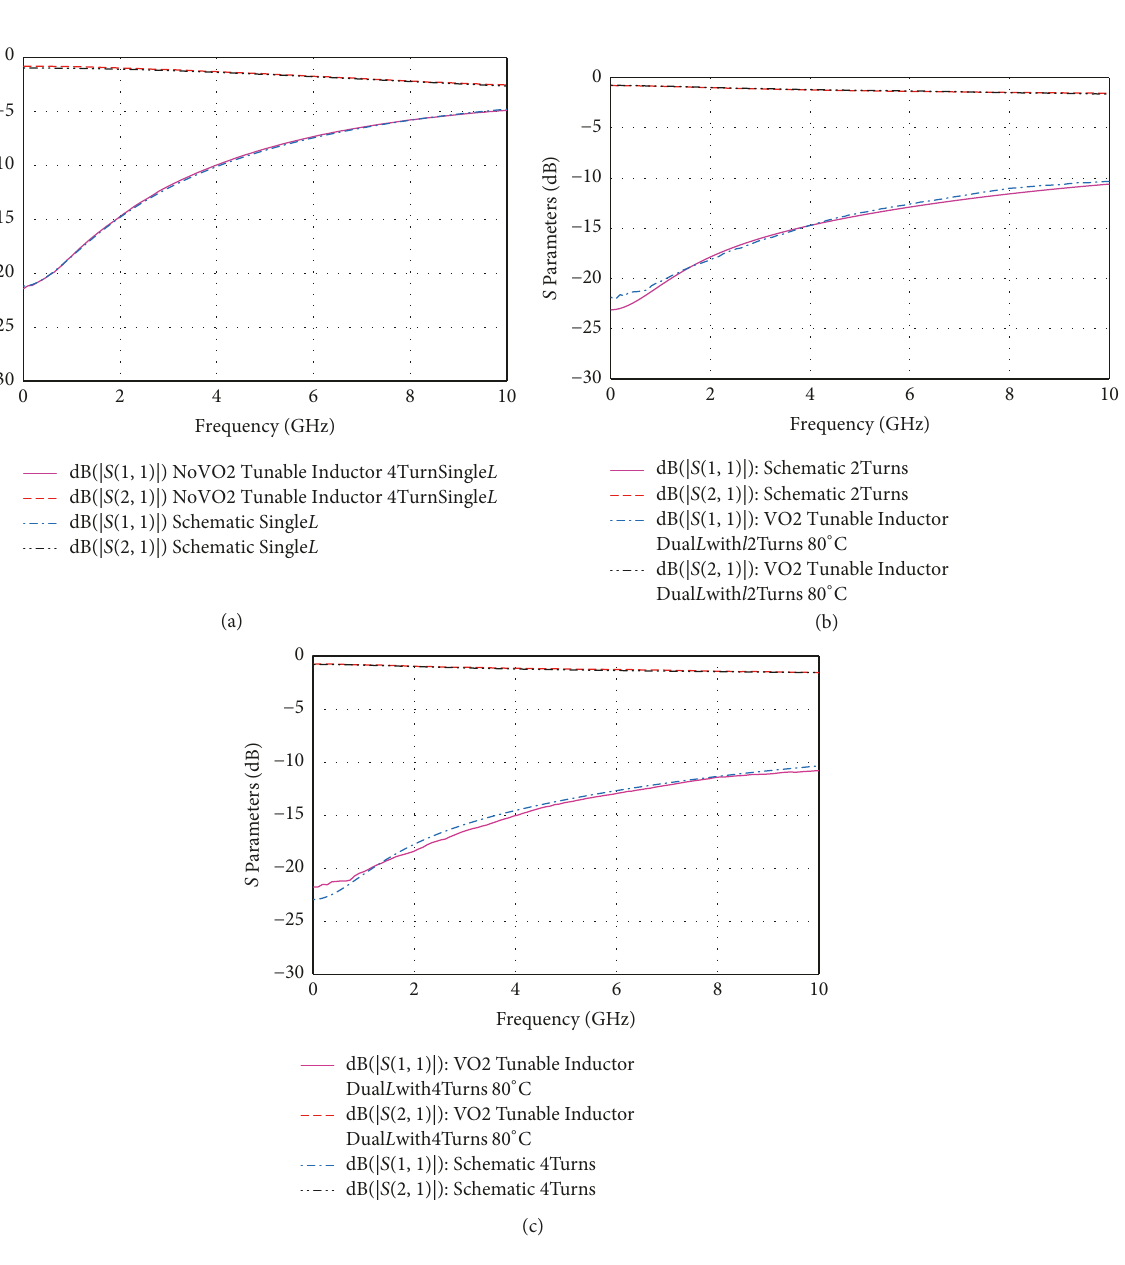
Figure 6: Scattering parameter of the experimental results and the equivalent circuit model at 80 ∘ C for (a) single line coil inductor, (b) dual line coil inductor with two turns, and (c) dual line coil inductor with four turns.